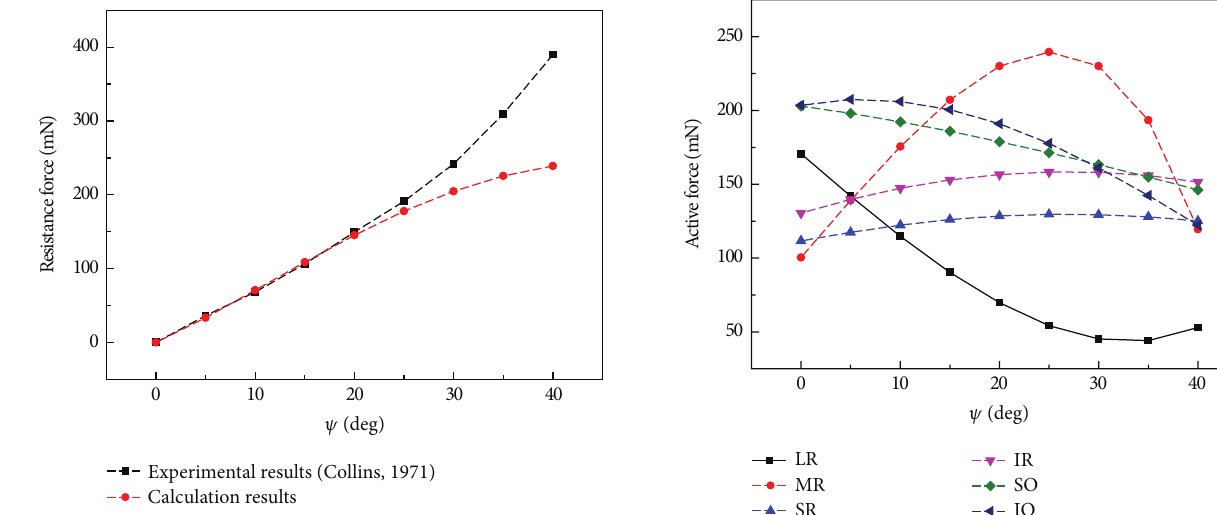
Figure 6: Active forces of EOMs with eye passively rotated tempo- ralward in the primary